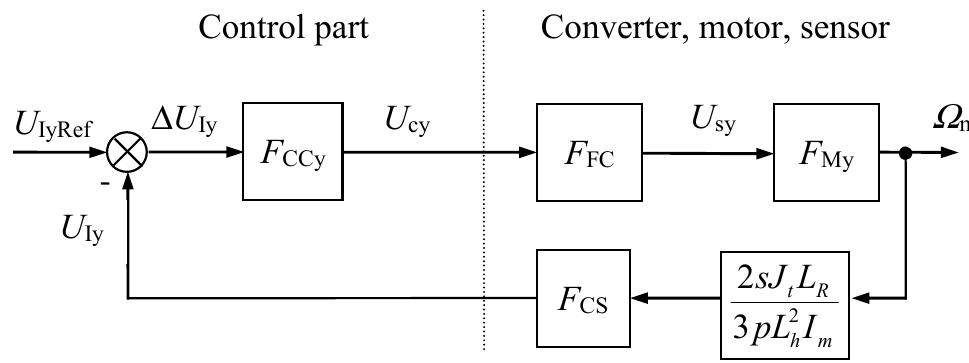
Figure 5. Adjusted torque-producing stator current control structure without decoupling block.